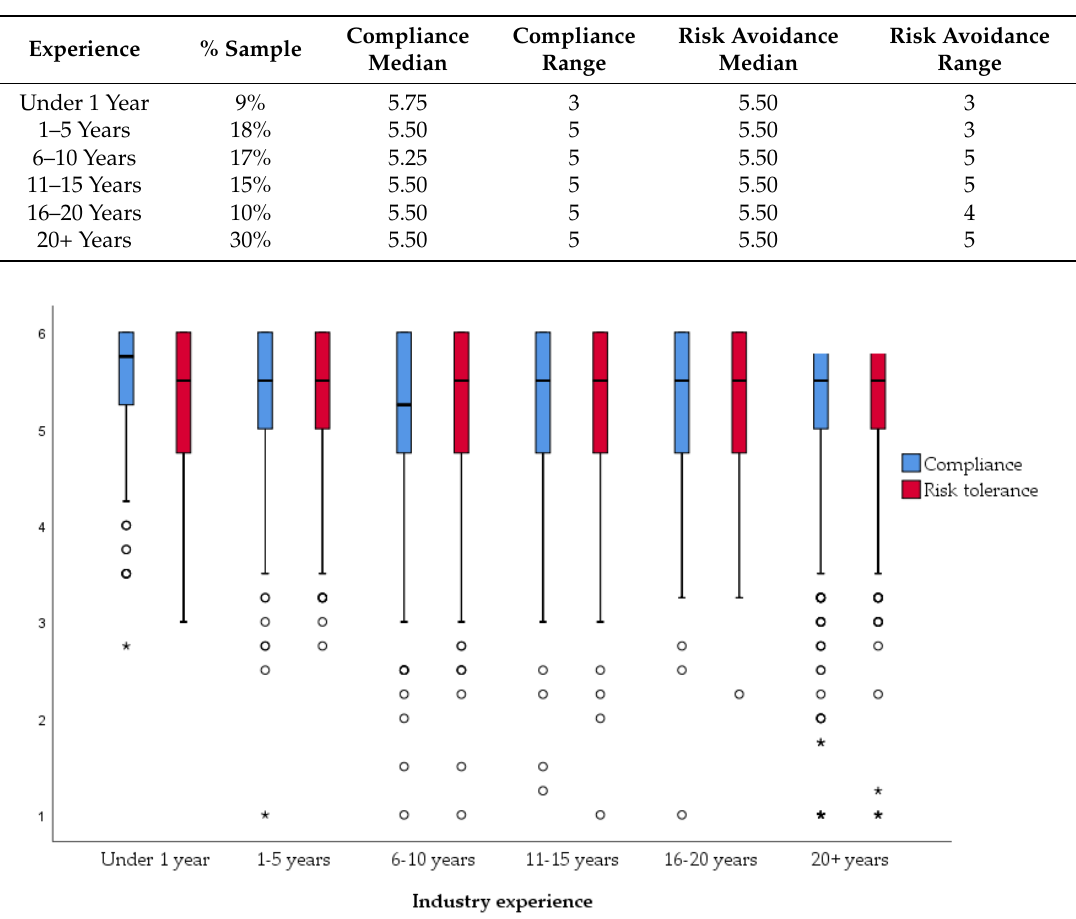
Table 5. Survey scale median and range by industry experience level.